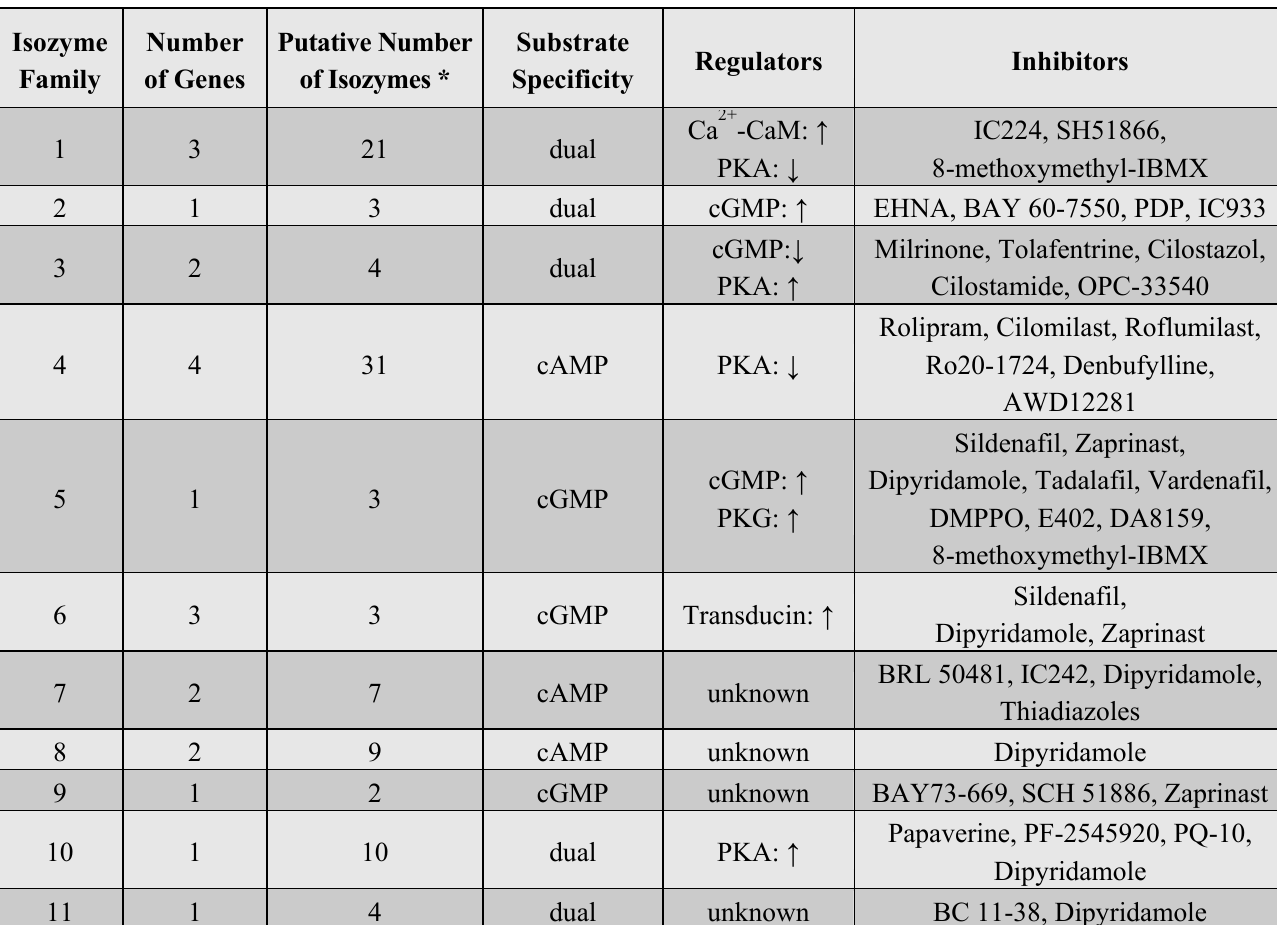
Table 1. Human PDE isozymes are divided into 11 families and differ according to substrate specificity, mechanisms of regulation, and sensitivity to inhibitors [12–17,20,21]. ↑ represents an increase in catalytic activity, whereas ↓ represents a decrease in catalytic activity. * Number of isozymes refers to the number of distinct protein products derived from all genes within a given family that have been identified to